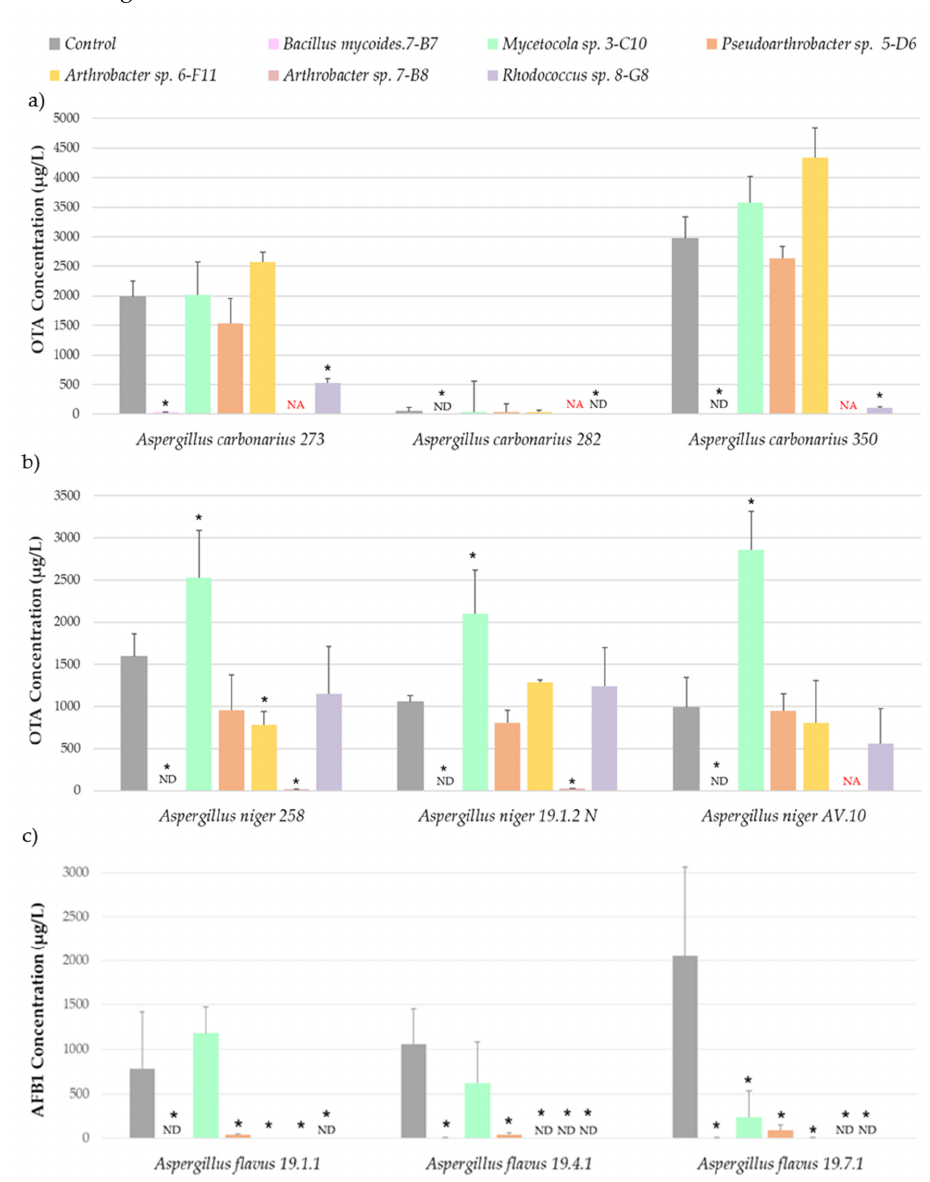
Figure 2. Ochratoxin A and aflatoxin B 1 concentration of the three Aspergillus carbonarius ( a ), A. niger ( b ) and A. flavus ( c ) isolates tested after being co-cultured with the corresponding bacteria. The bars indicate the mean of the three biological replicates and the thin lines their standard deviation values. The asterisks above each of the bars indicate statistically significant differences with respect to the control generated in Fisher’s LSD test ( p < 0.05). ND, non-detected; NA, not analyzed because the fungus was unable to grow in this condition.